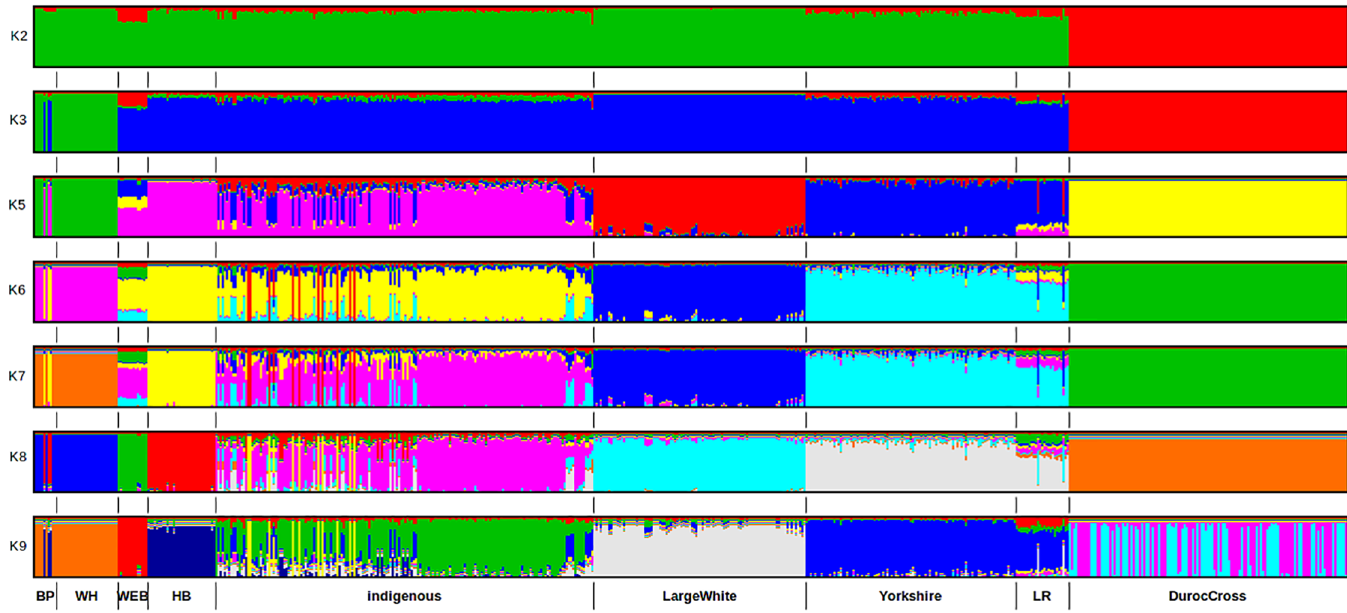
PLOS ONE | https://doi.org/10.1371/journal.pone.0190080 January 22,